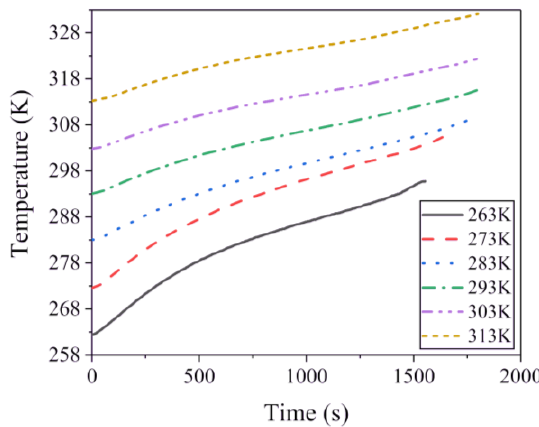
Figure 3. Temperature rise in natural state at different ambient temperature.